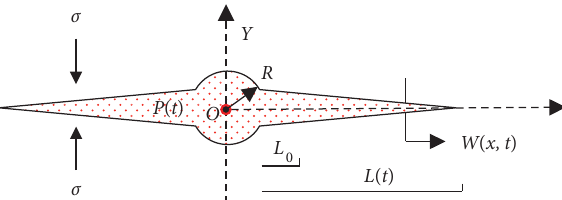
Figure 2: Planer wedge-shaped crack propagation model